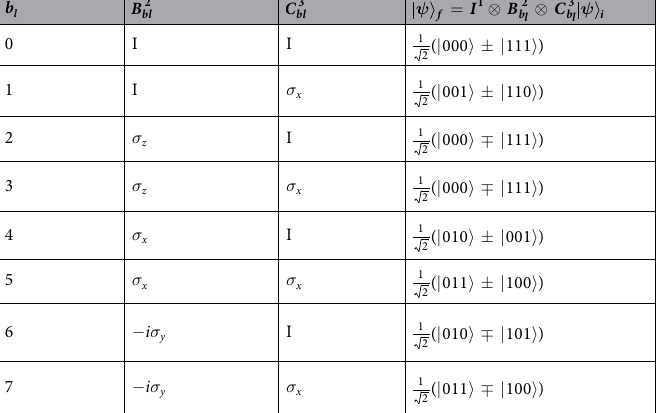
Table 1. Here, initially the particles 1, 2 and 3 are in the GHZ state ψ = determined by the result of the GHZ measurement on the rest qubits 4, 5 and 6. After a certain operation, the three qubits will be in the final state ψ